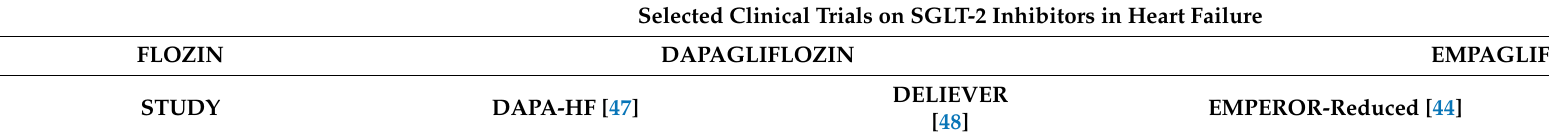
Table 3. Comparison of double-blind, randomized clinical trials on dapagliflozin and empagliflozin in Heart failure